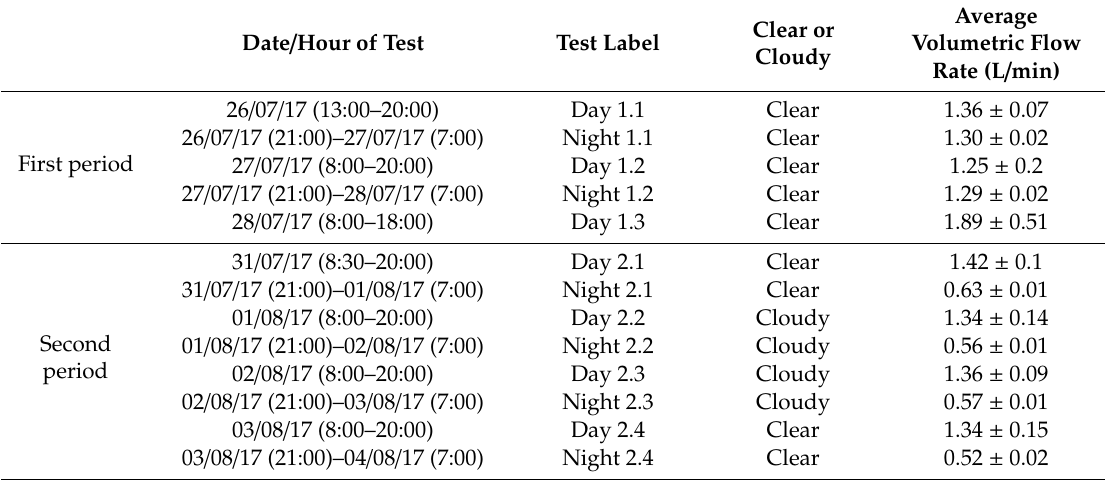
Table 2. Operating characteristics of the testing